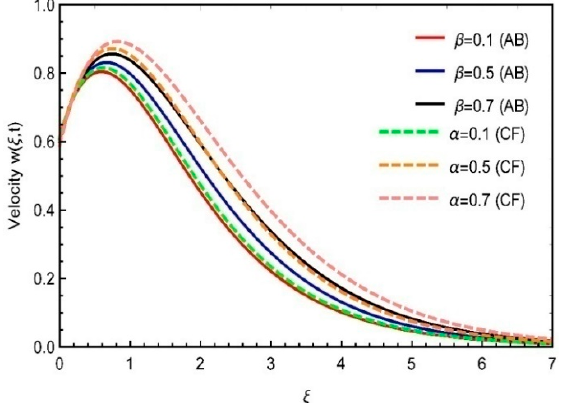
Figure 4. Change in velocity for 𝛼 and 𝛽.